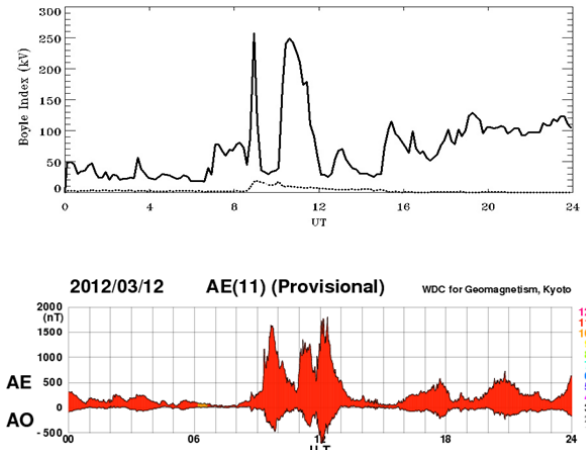
Figure 3. The upper panel indicates the Boyle index, which is an asymptotic polar cap potential (kV), on 12 March 2012 calculated from the solar wind parameters. The solar wind dynamic pressure (in units of nPa) is also shown with dotted line in the upper panel. The lower panel indicates the provisional geomagnetic field indices (AE and AO) on 12 March 2012. The number of stations used to derive the indices is shown in